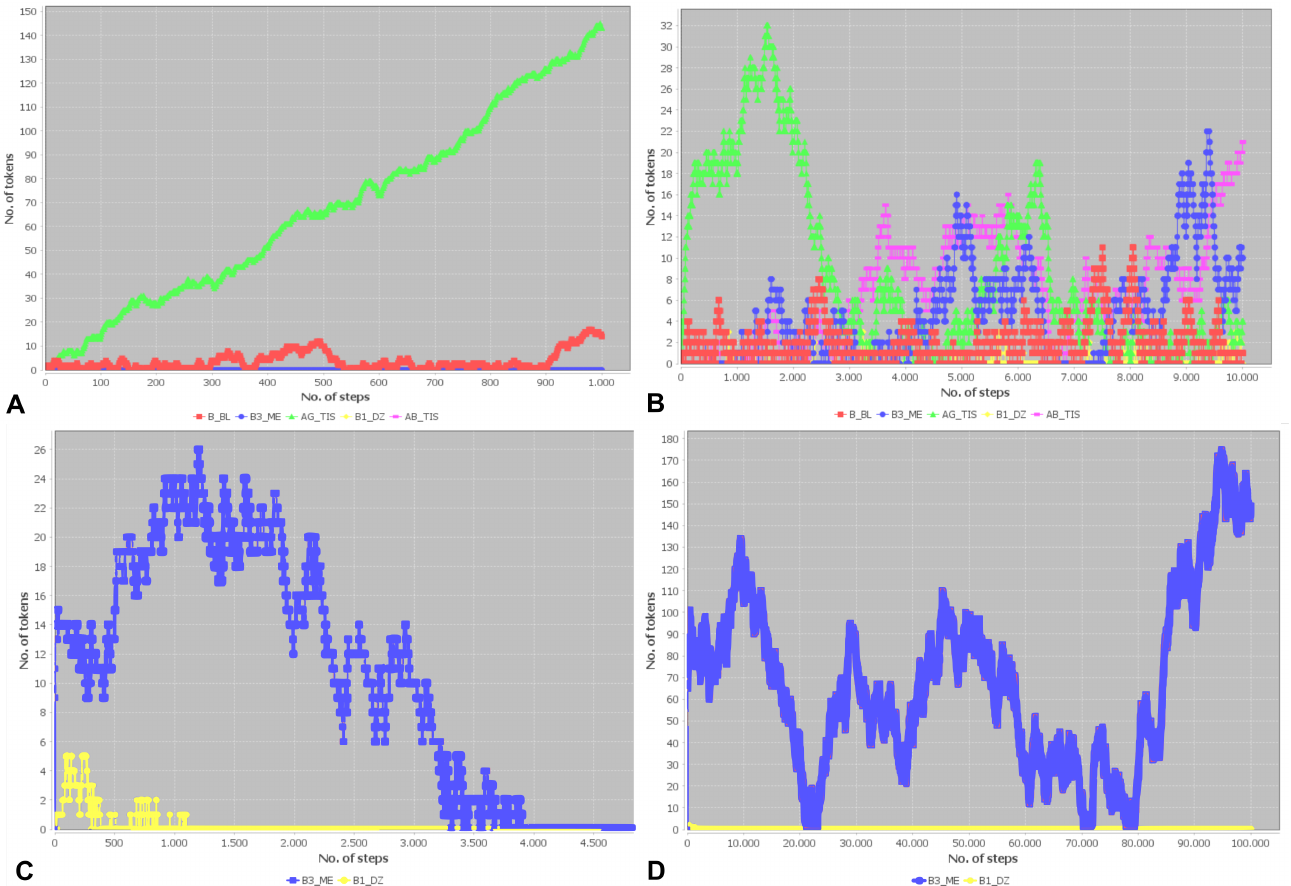
Figure 7. Token flows for various initial physiological conditions. The figures depict the number of antigens (green dots), memory B cells (blue dots), B cells in the blood (red dots), activated B cells (yellow dots), and antibodies (pink dots). ( A ): Initial condition without cells. The antigens accumulate monotonically. No memory B cells are produced, and no immune response is triggered. ( B ): Initial condition with 100 T cells, 100 dendritic cells, 100 antigen-presenting cells, and 100 macrophages. The antigens accumulate only in the initial phase. The system adapts to the antigen. After around 1500 steps, the number of antibodies increases and the number of antigens drops. An adaptive immune response takes place. ( C ): The initial condition is an adapted system (10,000 steps) with no further inflow of antigens. After around 3500 steps, the number of memory B cells drops again to zero. The system loses its memory of the antigen. ( D ): The initial condition is an adapted system (20,000 steps) with no further inflow of antigens. A high number of memory B cells makes the system robust against memory loss. Even after 100,000 steps, the number of memory B cells remains nonzero. Eventually, the number of memory B cells randomly drops to zero and the system loses its memory to the